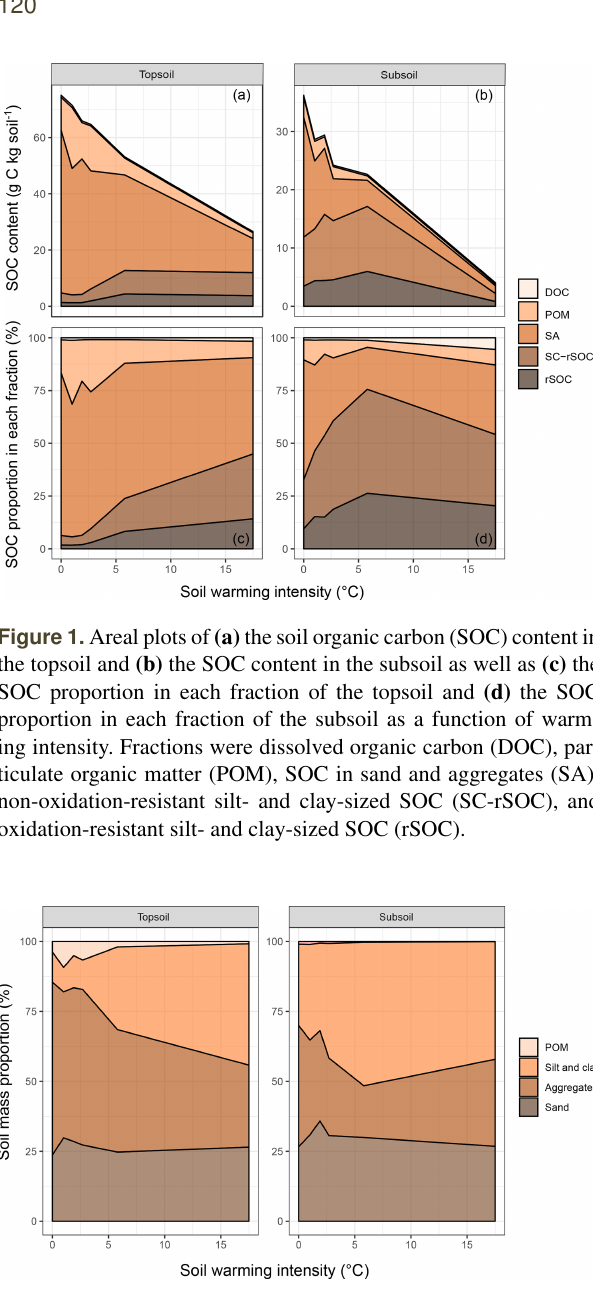
Figure 2. Areal plots of the soil mass distribution in the particulate organic matter (POM), sand and stable aggregates (SA), and silt and clay (SC) fractions as a function of warming intensity.